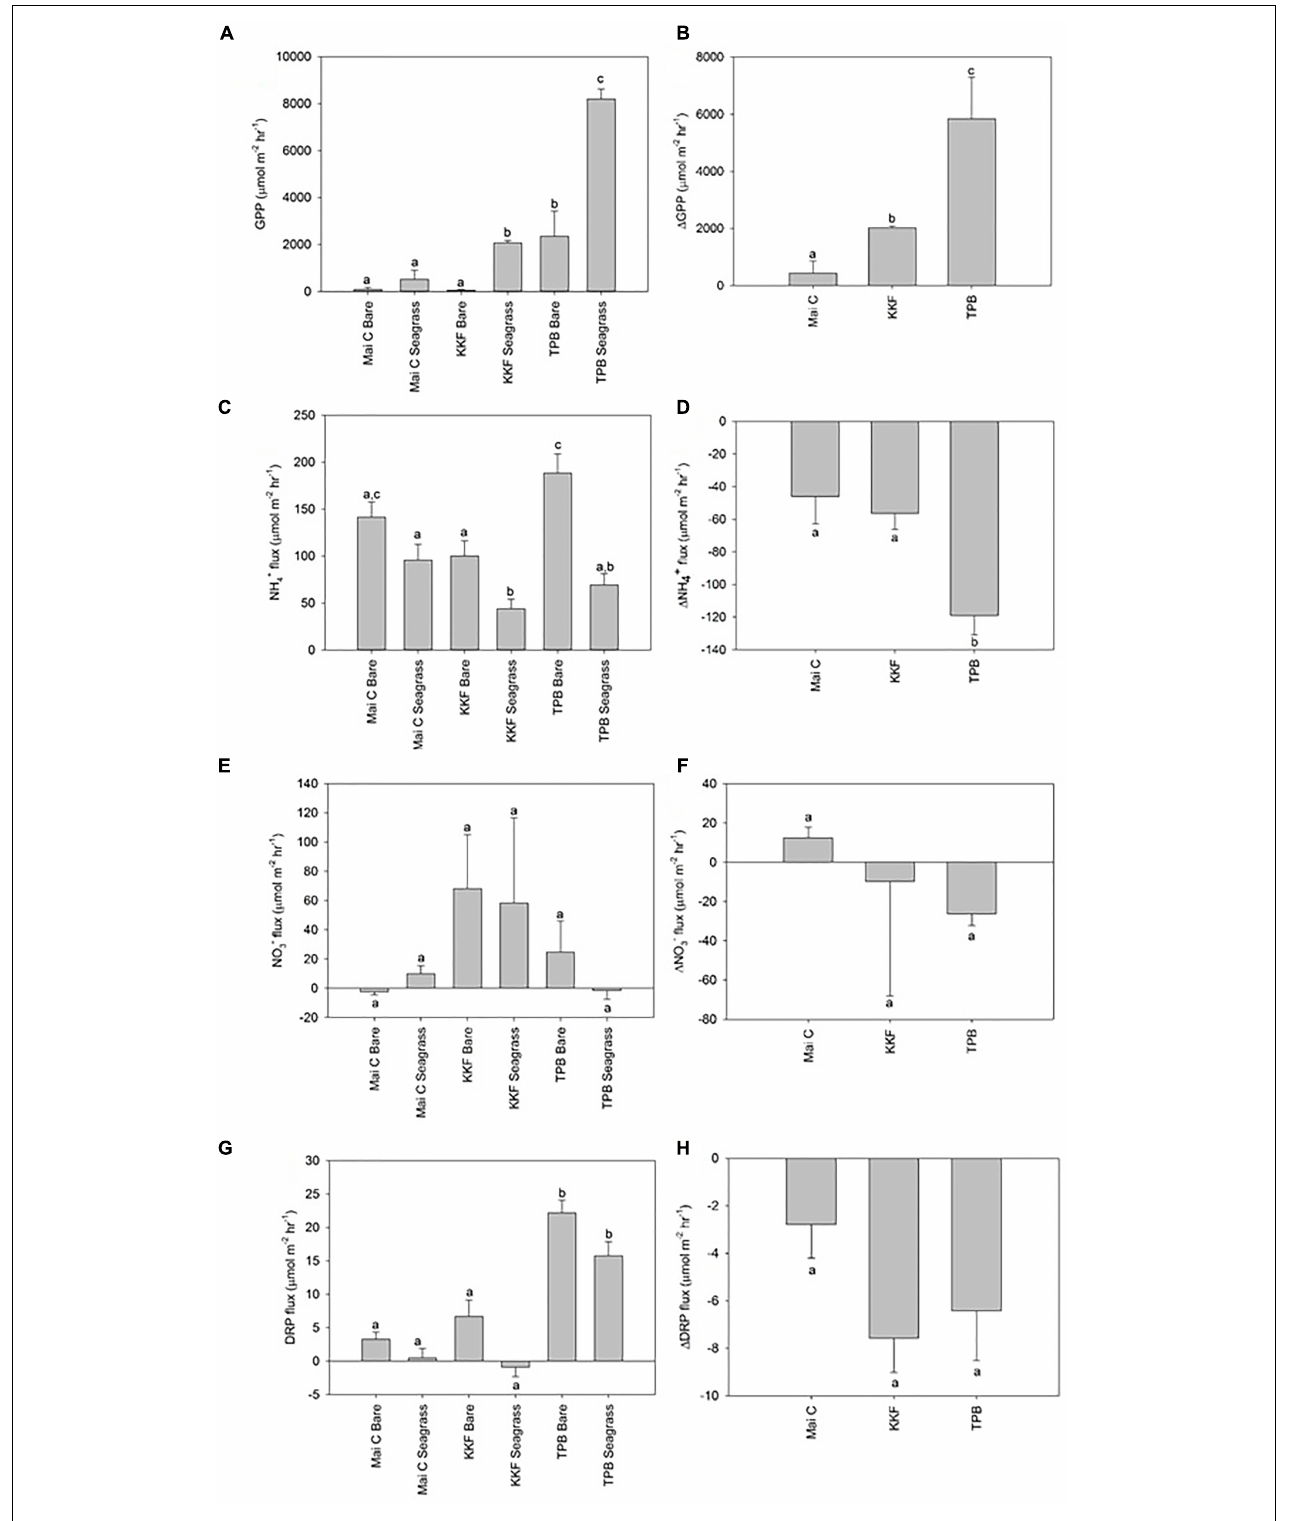
FIGURE 3 | Dissolved oxygen and inorganic nutrient sediment-water column fluxes from seagrass and bare sediment at three sites ± 1 standard error. (cid:49) represent seagrass minus adjacent bare sediment fluxes at each site. (A) Gross Primary Production (GPP), (B) (cid:49) GPP, (C) NH 4 + flux, (D) (cid:49) NH 4 + flux, (E) NO 3 − flux, (F) (cid:49) NO 3 − flux, (G) DRP flux, (H) (cid:49) DRP flux. n = 10 per site/habitat type. a , b , c same letter indicates no significant difference (p > 0.05) .